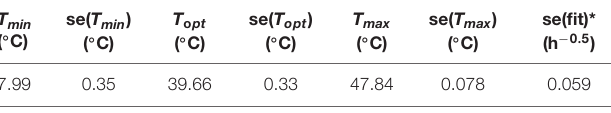
TABLE 2 | Cardinal values of strain F4810/72 estimated on BHI data and assumed to be valid for food matrices, too.